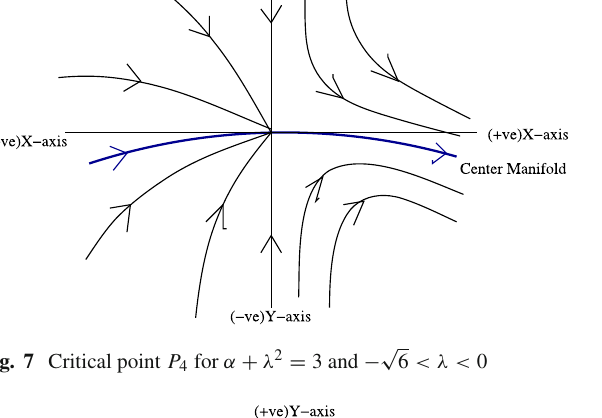
Fig. 7 Critical point P 4 for α + λ 2 = 3 and